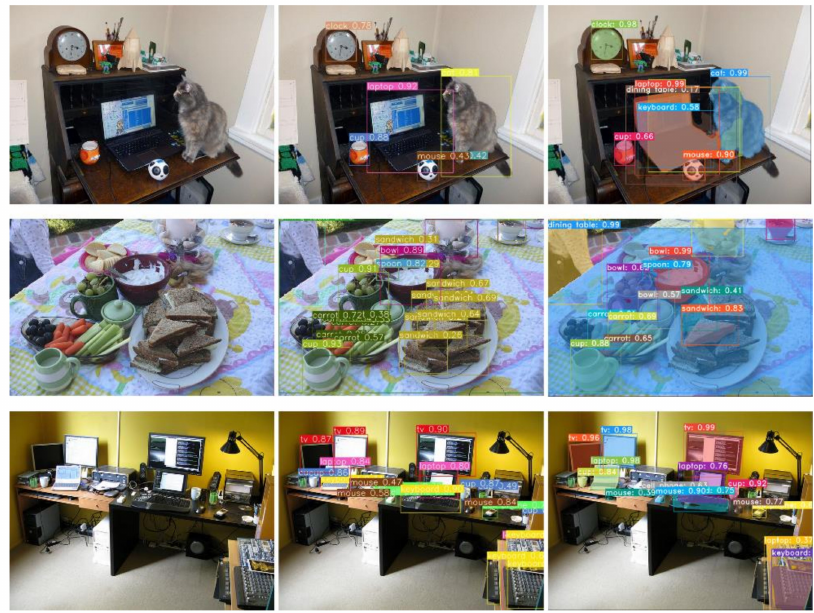
Figure 7. Detection results of multiple targets in complex background. The left column is the original image, the middle column is the detection effect of the object detection network, and the right column is the detection effect of the proposed algorithm, which proves that the effect of the fusion network is better than that of the single object